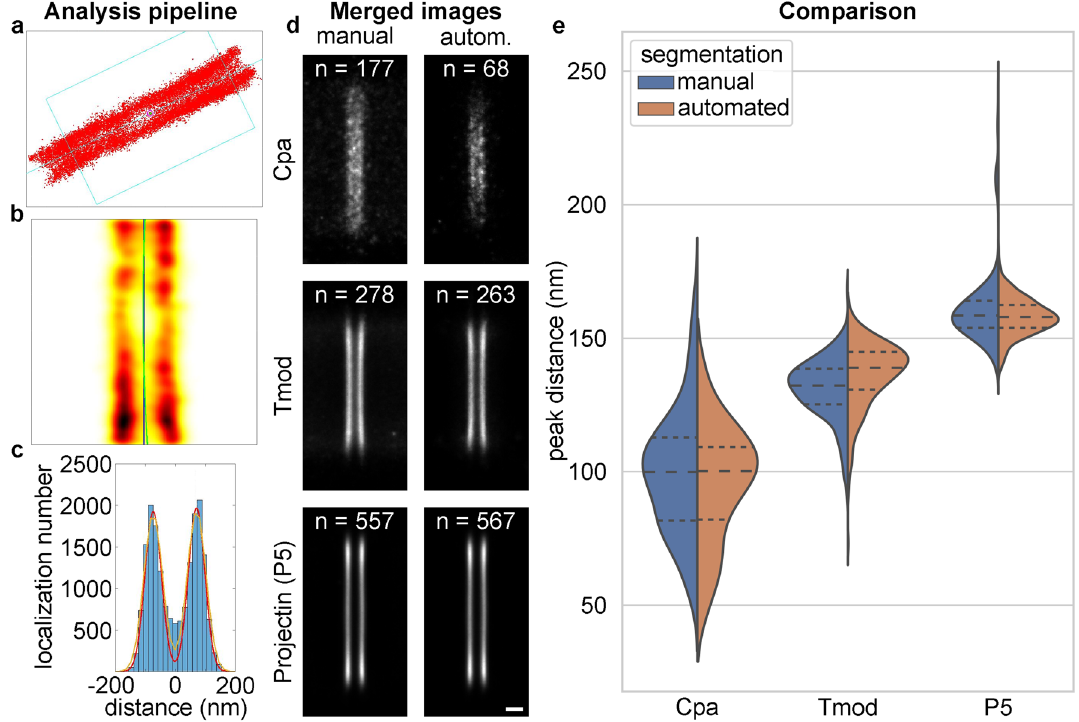
localizations and the symmetry axis (green curve) fitted to it. ( c ) Distance of the localizations from the symmetry axis and the curve fitted to the distribution (yellow curve) and its correction (red curve). ( d ) Spatial distribution of three proteins labelled with different quality after the structural averaging of dSTORM images for manual and automated segmentation ( Cpa Capping protein alpha, T mod Tropomodulin and Projectin (P5)). ( e ) Comparison of the measured relative positions of proteins for manual and automated segmentation. Scale bar 200 nm ( d ).